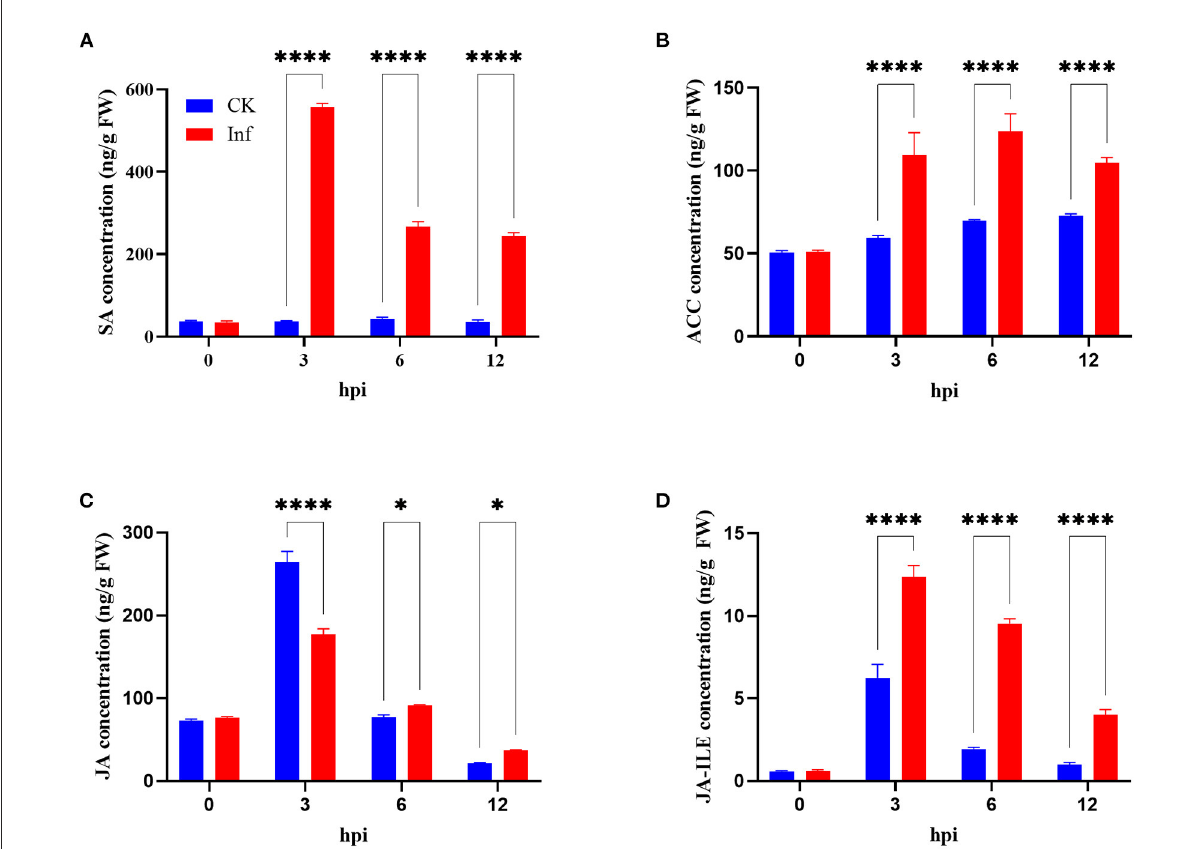
FIGURE8 Changes in phytohormone levels in maize after Ustilago maydis infection. (A–D) Total content of salicylic acid (SA), ethylene precursor (ACC), jasmonate (JA), and jasmonoyl-isoleucine (JA-ILE) in U. maydis -infected (red bars) and control leaves (blue bars) at 0, 3, 6, and 12 hpi, respectively. Data represent mean ± SD (three biological replicates from seven leaves). Statistically significant differences between control and U. maydis -infected samples determined based on Student’s t- test are indicated (* P < 0.05; **** P < 0.0001).